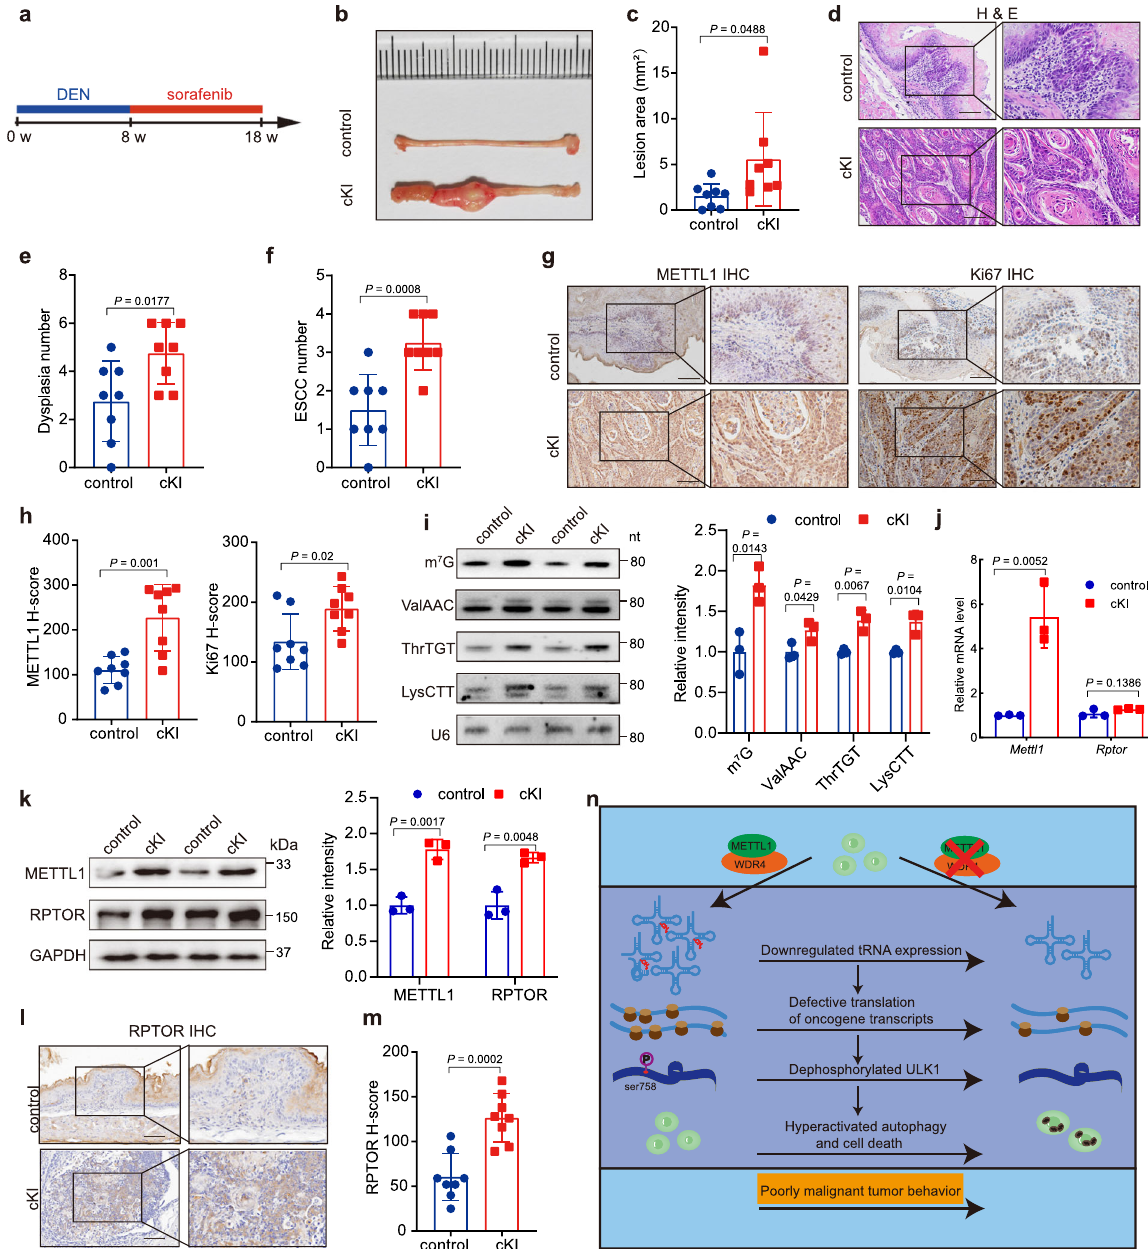
Fig. 7 METTL1 overexpression promotes in vivo ESCC tumorigenesis. a Experimental design for ESCC tumorigenesis model in Mettl1 cKI and control mice. b Representative images of esophageal lesions from Mettl1 cKI and control mice. c Quanti fi cation of lesion areas in Mettl1 cKI and control mice. d Representative H&E staining of esophagus tissues in Mettl1 cKI and control mice. Scale bar, 100 μ m. e , f Quanti fi cation of dysplasia numbers ( e ) and ESCC numbers ( f ) in Mettl1 cKI and control mice. g , h Representative images ( g ) and the quanti fi cation ( h ) of METTL1 and Ki67 IHC staining in Mettl1 cKI and control mice. Scale bar, 100 μ m. i Northwestern blot and northern blot detected the m 7 G level and m 7 G-modi fi ed tRNA expression level in tumors from Mettl1 cKI and control mice, right panel: quanti fi cation of the blot signals. j qRT-PCR assay showed the mRNA levels of indicated mRNAs. k Western blot showed the indicated protein levels in the cKI and control mice, right panel: quanti fi cation of the western blot signals. l , m Representative images ( l ) and the quanti fi cation ( m ) of RPTOR IHC staining in Mettl1 cKI and control mice. Scale bar, 100 μ m. n Working model for METTL1/WDR4 mediated tRNA m 7 G modi fi cation in regulation of ESCC tumorigenesis. Data represented as mean ± SD by two-tailed unpaired Student ’ s t test for all. n = 3 biological independent samples for ( i – k ) and n = 8 biological independent samples for ( b – h and l , m